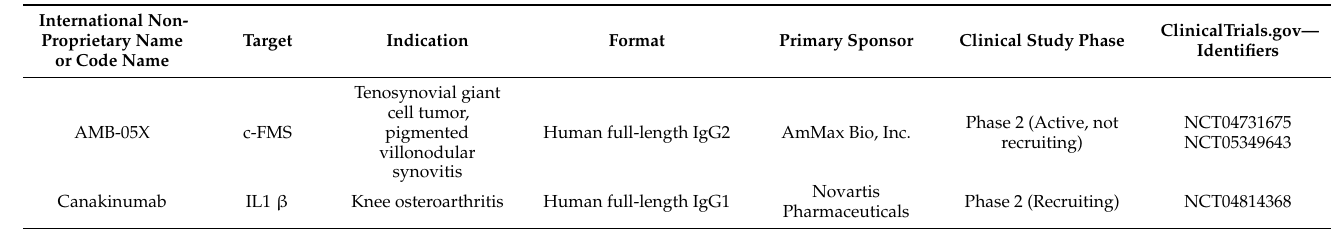
Table 8. Therapeutic antibodies in development delivered by intra-articular administration, currently in Phase 2 of clinical